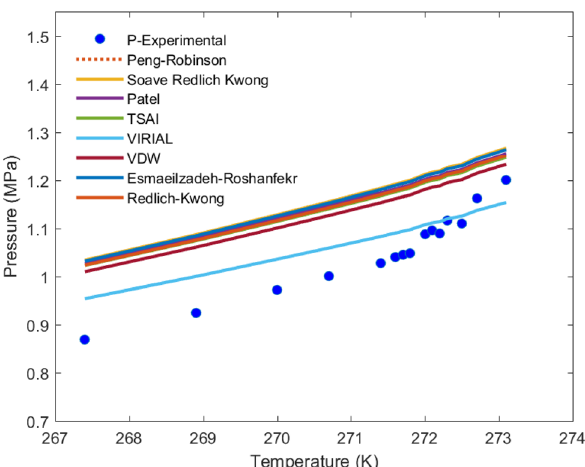
Fig. 7 Predicted pressure versus experimental plot for I – H – V phase region, AAD %, [Min/Max] of [4.2/12.9]